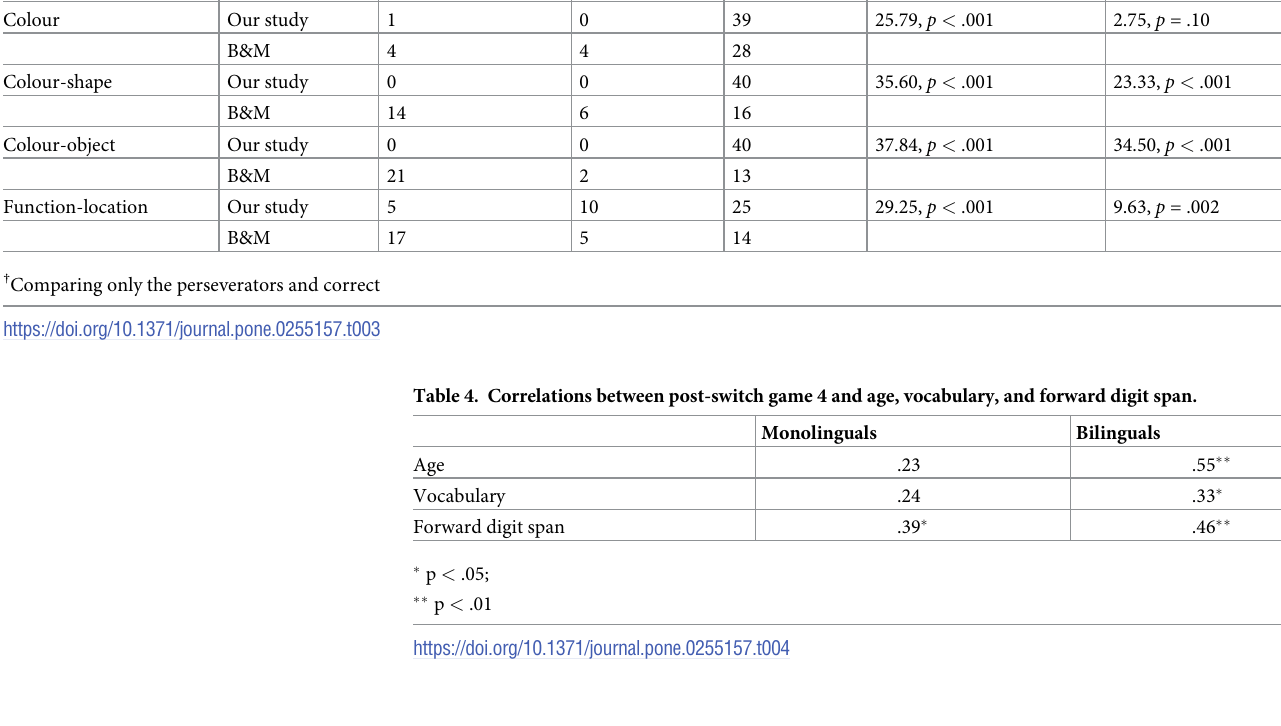
Table 3. Distribution comparison of the monolinguals in the present study and Bialystok and Martin’s (2004) study. Condition